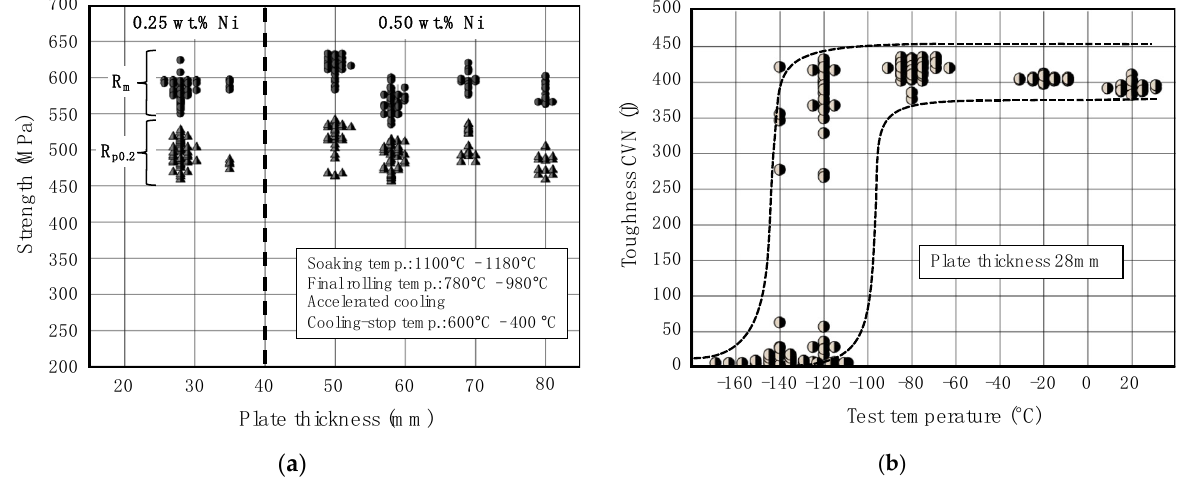
Figure 13. ( a ) Strength properties obtained by plate-mill trials with a 0.03 wt.% C–1.5 wt.% Mn–0.08 wt.% Nb steel and variable nickel alloying adapted to plate gauge. ( b ) Charpy V-notch toughness transition behavior for a respective steel plate with 28-mm thickness (all data taken at 1 / 4 thickness position in longitudinal and transverse direction).